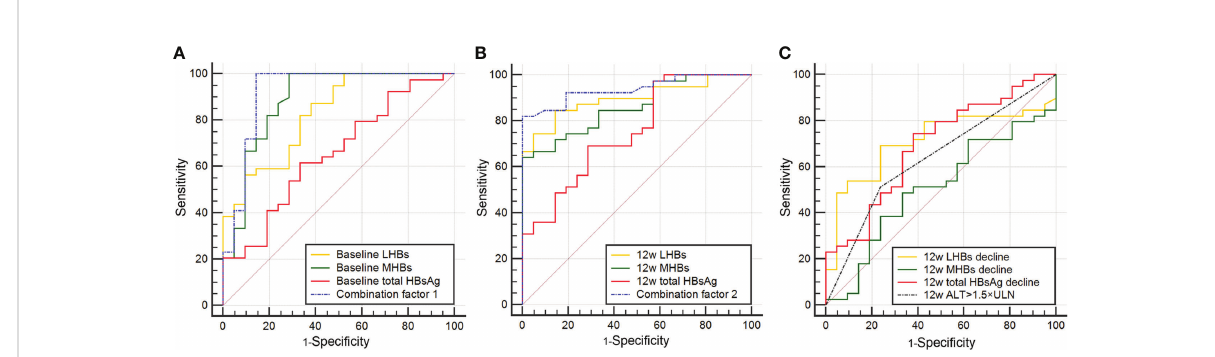
FIGURE 2 ROC curves of HBsAg clearance predictors. (A) ROC curves of total HBsAg, LHBs, MHBs, and combination factor 1 at baseline. (B) ROC curves of total HBsAg, LHBs, MHBs, and combination factor 2 at 12 weeks. (C) ROC curves of the degree of decline in total HBsAg, LHBs, and MHBs from baseline to 12 weeks, and ALT elevations >1.5 × ULN at 12 weeks.